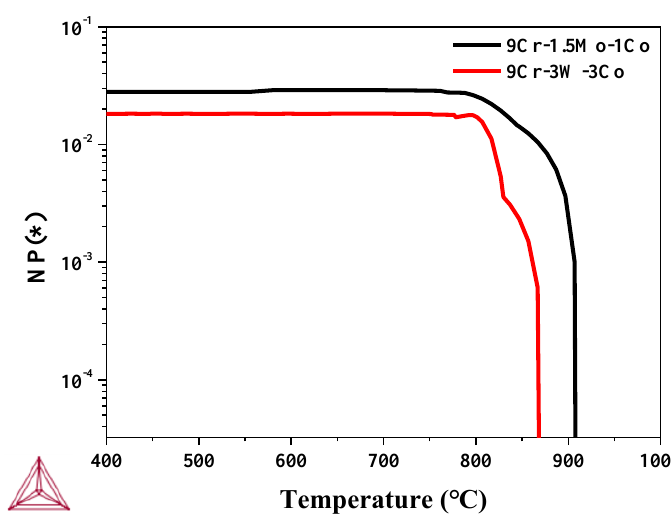
Figure 17. Change of precipitation amount of M 23 C 6 precipitate with temperature.